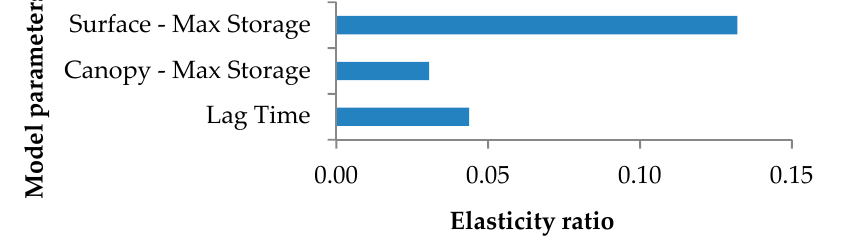
Figure 9. Model parameter elasticity ratio.